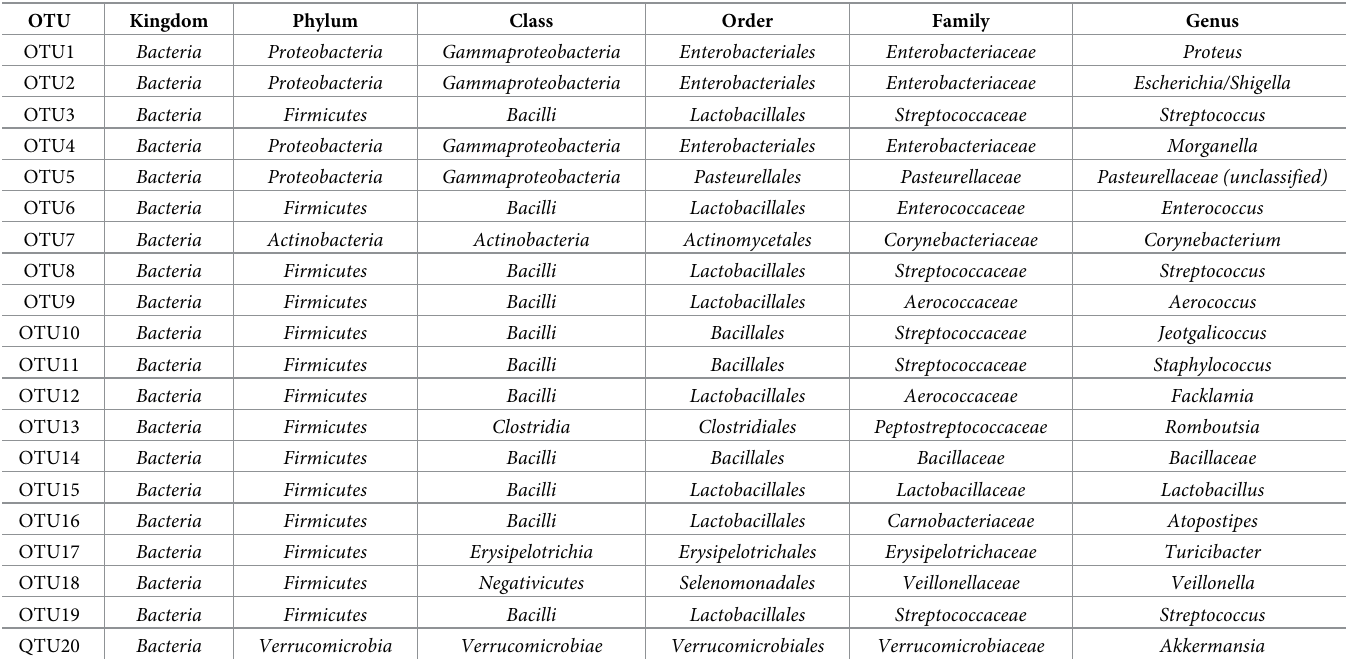
Table 1. Taxonomic ranking of twenty most abundant OTU.